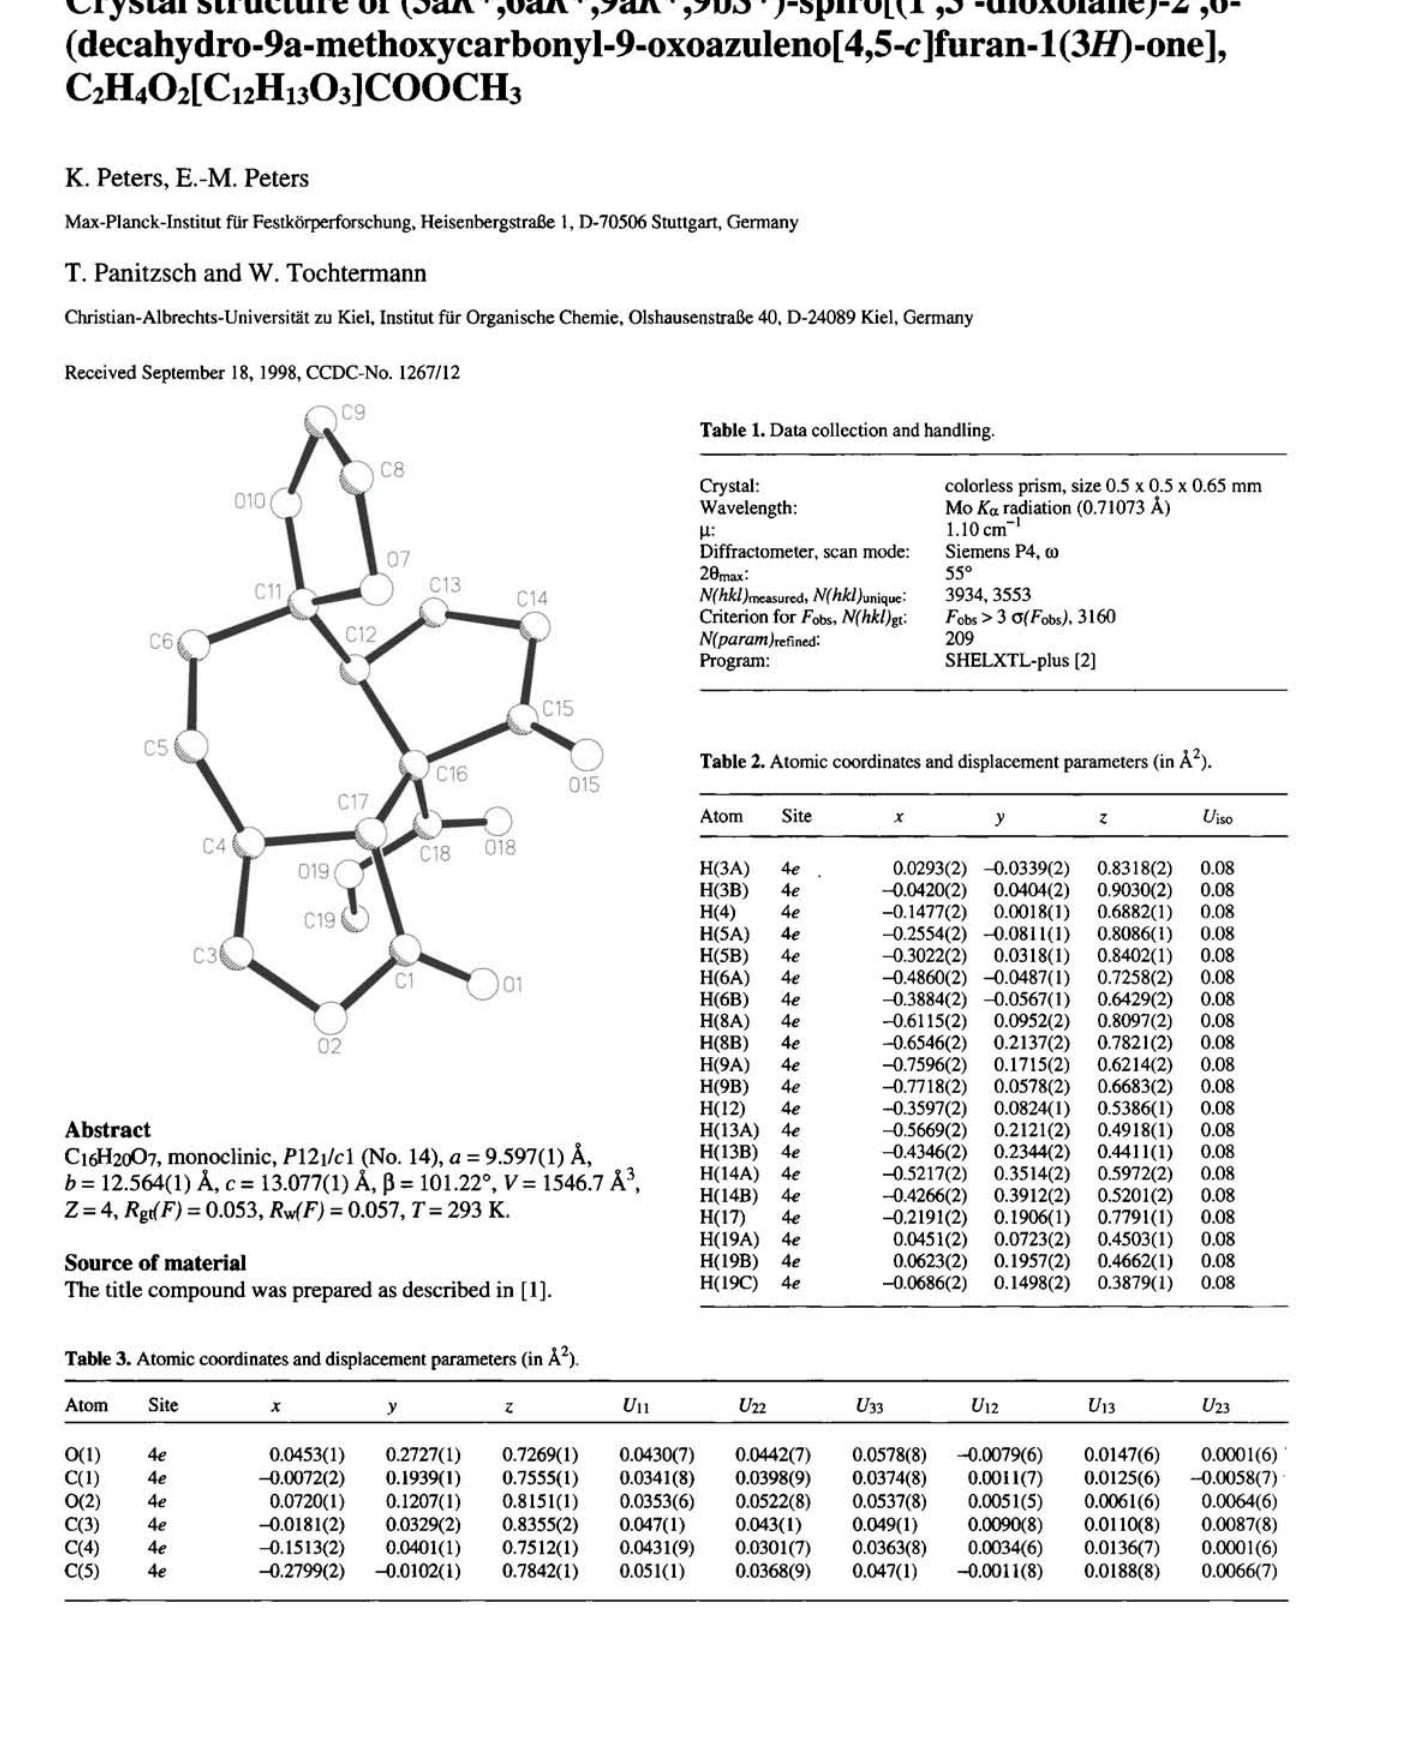
Table 1. Data collection and handling. Crystal: